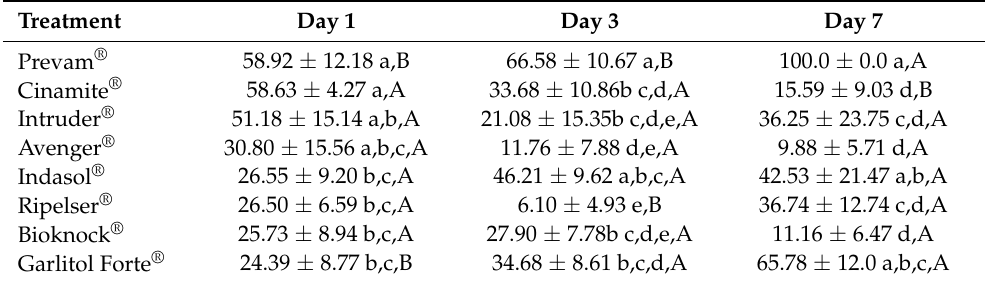
Table 2. Henderson–Tilton efficacy values on banana bunches 1 day, 3 days, and 7 days post application a